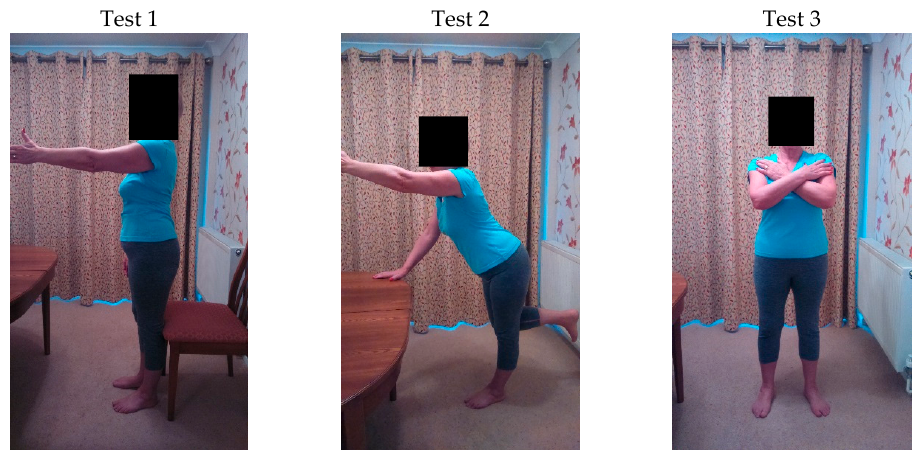
Figure 1. Participant carrying out the Movement Screening Tests: Test 1, sit to stand with arm lift; Test 2, trunk lean with knee bend and opposite arm lift; Test 3, chest rotation with neutral head and pelvis.